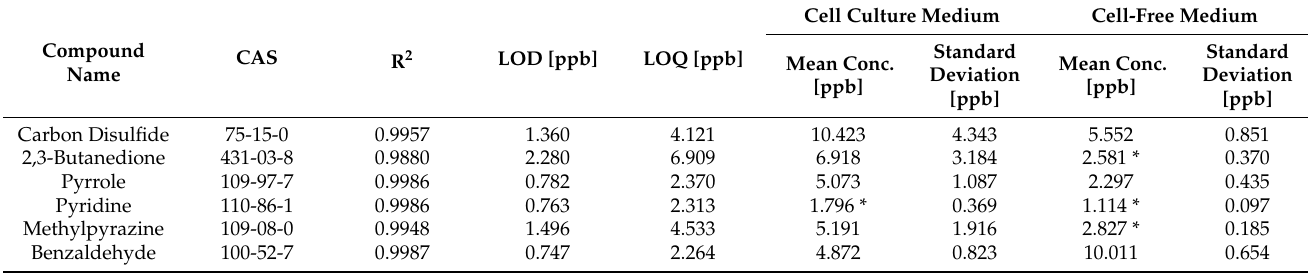
Figure 5. VOCs detected at significantly higher (respectively, lower) levels in the headspace of A549 cell culture medium (red boxes) compared to the reference sample of cell-free RPMI-1640 medium control (blue boxes). Boxes represent the 25th, 50th and 75th percentile, while whiskers refer to the 5th and 95th percentile. Mean values are indicated with a yellow diamond. Table 1. Concentration [ppb] of target volatiles measured in the headspace samples of cell culture medium and cell-free reference medium along with calibration parameters. Concentrations higher than LOD but lower than LOQ are labeled with an